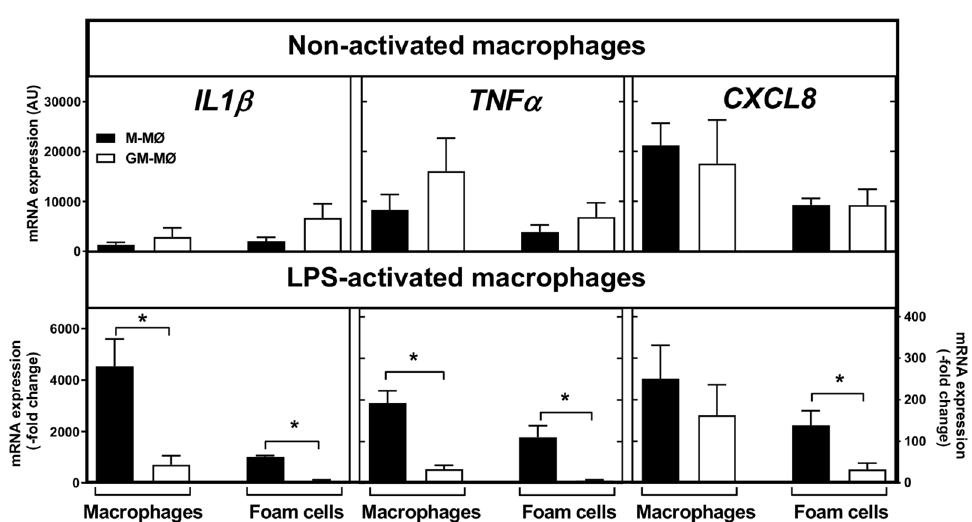
Figure 4. Gene expression of inflammatory cytokines in cholesterol-loaded M-MØ and GM-MØ after LPS activation. The mRNA expression of 3 key cytokines with proinflammatory properties (IL-1β, TNF-α, and CXCL8) by activated human macrophages was evaluated after incubation of non-loaded macrophages (“Macrophages”) and cholesterol-loaded macrophages (“Foam Cells”) of each CSF subtype for 3 h with LPS. The cytokine expression in LPS-activated macrophages (bottom panels) was expressed as fold-changes relative to their levels in the respective non-activated MØ subtypes (top panels). For each condition, data are presented as means ± SEM of 3 individual blood donors, and triplicate incubations for each condition. *p < 0.05 denotes statistically significant differences determined by Wilcoxon Signed-Rank test for paired